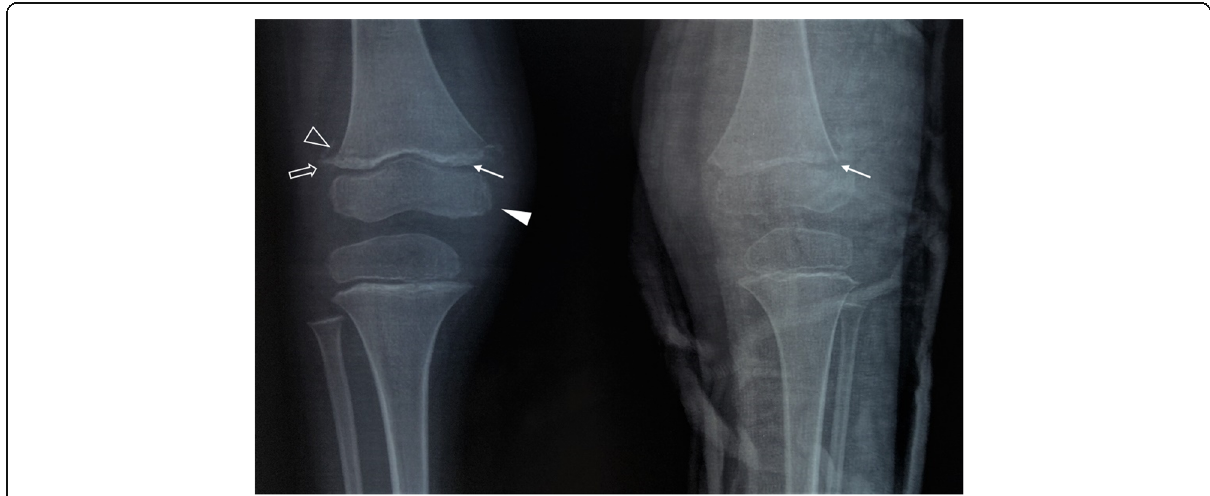
Fig. 4 Anteroposterior radiograph of knee joint reveals metaphyseal dense bands in bilateral distal femoral metaphyses (white arrows) with adjacent proximal horizontal bands of radiolucency (open arrowhead) suggestive of zone of provisional calcification with Trummerfeld zones. Flaring at metaphyseal corners of distal femoral metaphysis (open arrows) suggestive of Pelkan spurs. Centrally lucent epiphysis with sharply marginated sclerotic rim (white arrowhead) (Wimberger ring sign). Similar findings also seen in bilateral proximal tibial physes. The findings